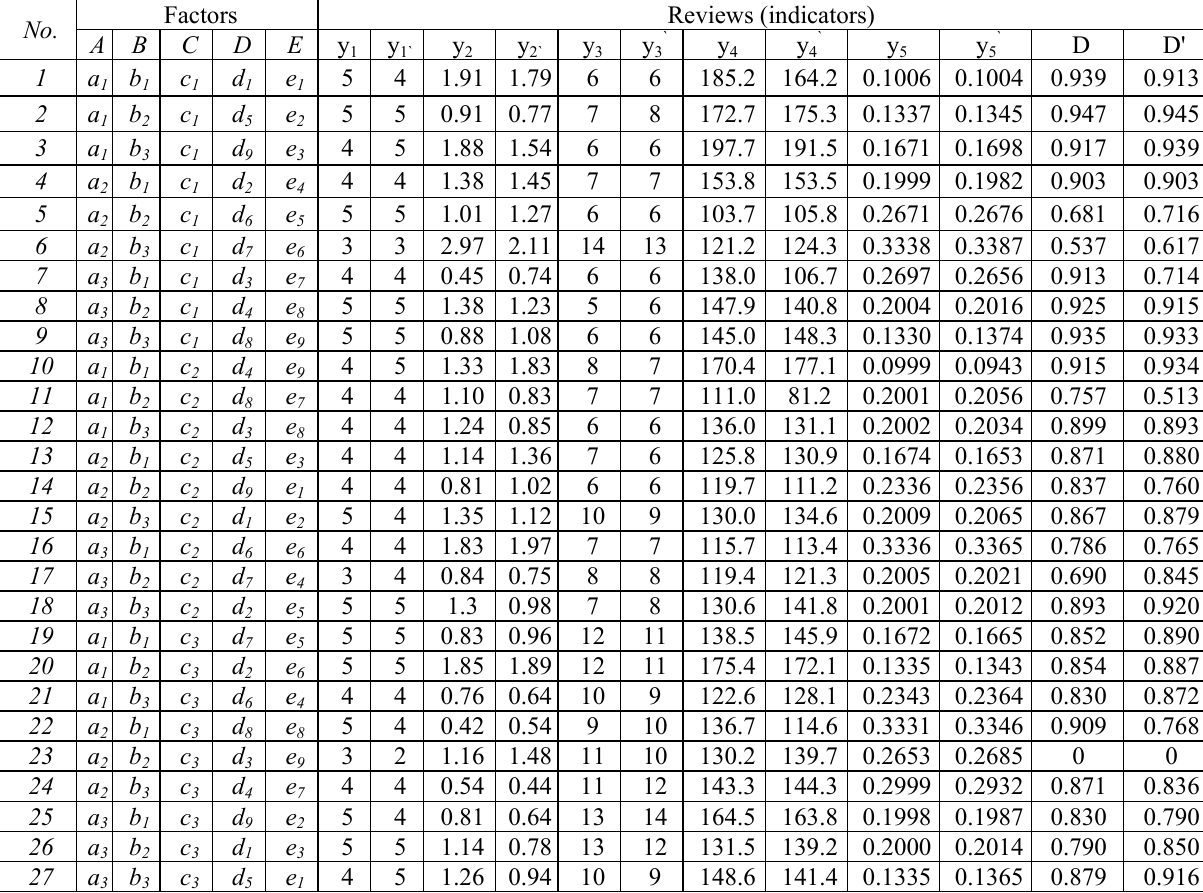
Experiment planning matrix and results of study of round-leaved wintergreen extract